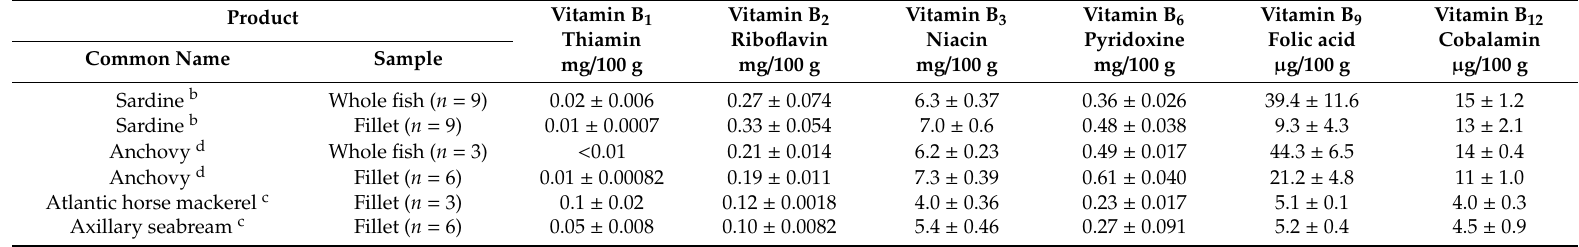
Table 7. Analytical values for the B-vitamins in di ff erent species of fish sampled on the EAF Dr. Fridtjof Nansen cruise from Tangier to Cap Bojador in May 2017 (mean ± SD) a